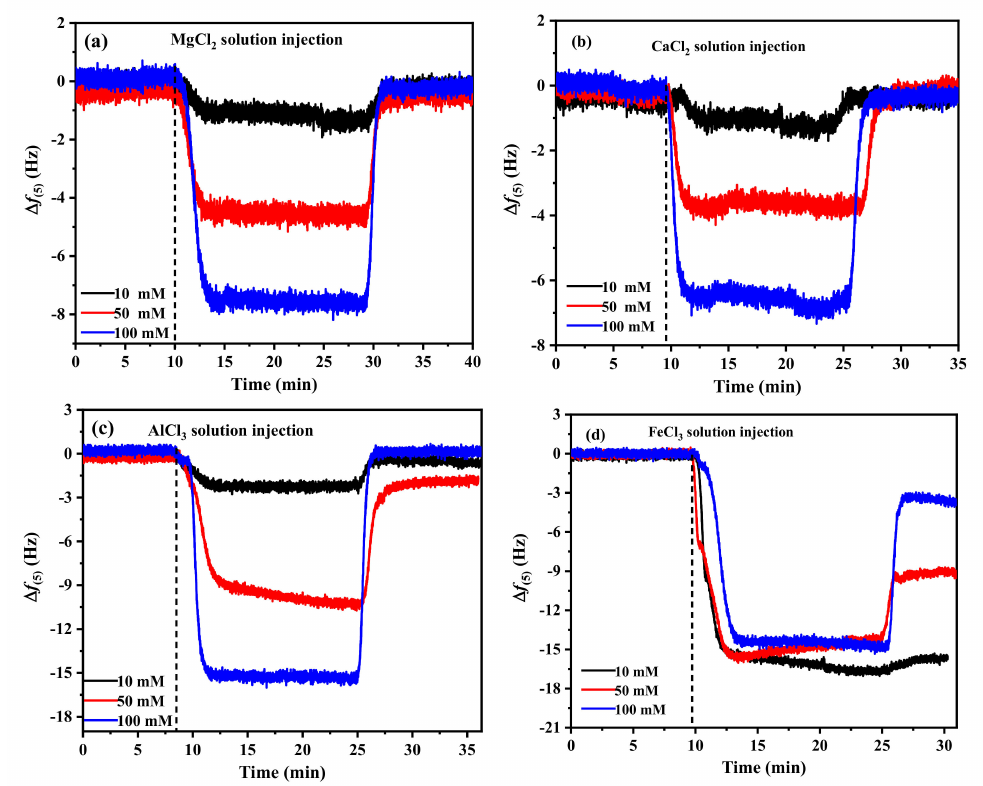
Figure 4. Change in frequency ( ∆ f) associated with the adsorption of different coagulants on QCM-D carbon sensors in 10 mM, 50 mM, and 100 mM solution. ( a ) MgCl 2 , ( b ) CaCl 2 , ( c ) AlCl 3 , ( d ) FeCl 3